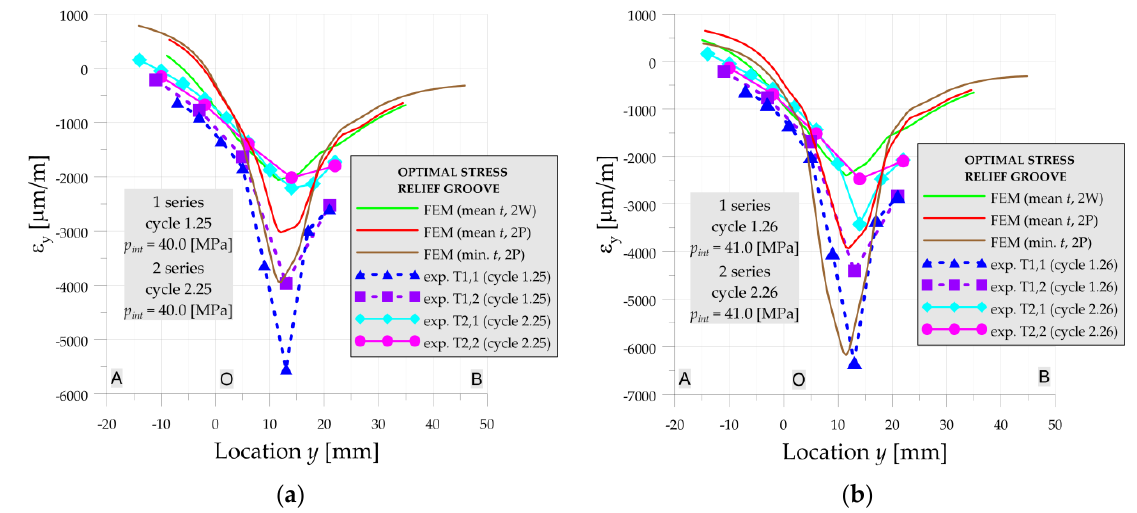
Figure 11. Numerical and experimental strains on line A-O-B, optimal SRG, 1st and 2nd series: ( a ) cycles 25; ( b ) cycle 26.